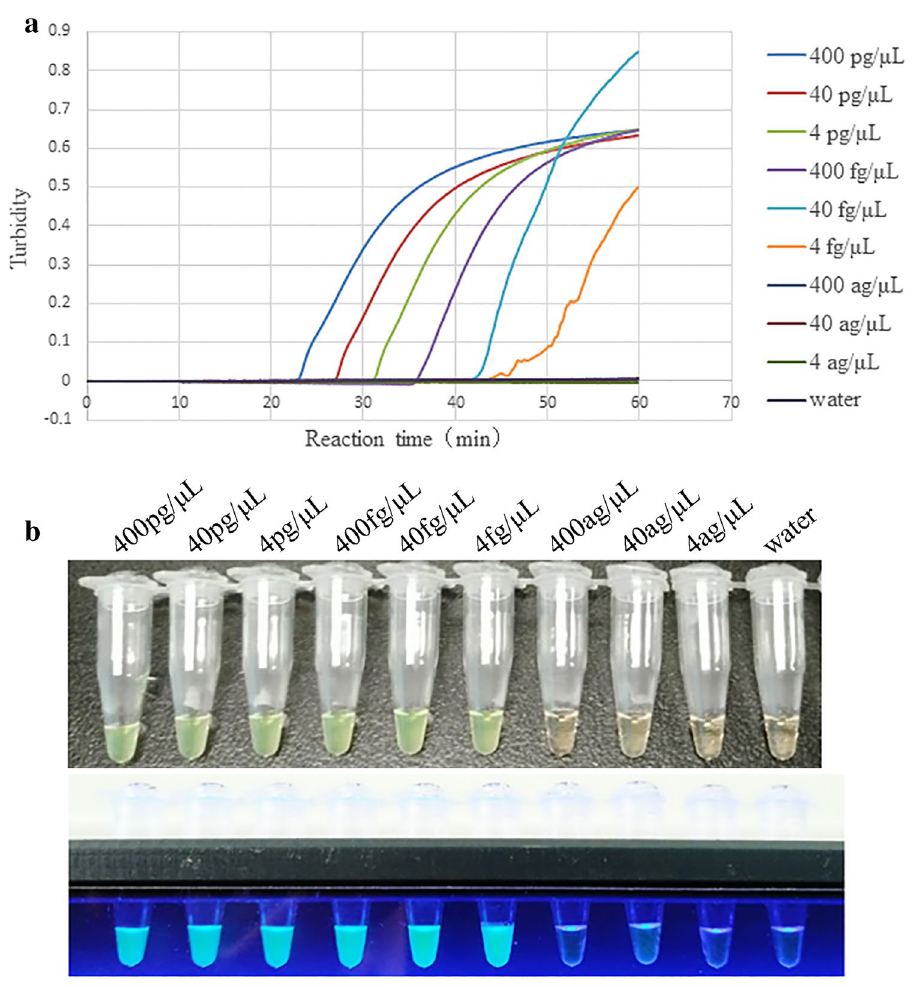
Figure 3. The sensitivity of the RT-LAMP assay based on the RS2 primers. ( a ) The turbidity curves generated by the Loopamp real-time turbidimeter, resulting in the final nucleic acid concentration of 4 ng/μL, 400 pg/μL,